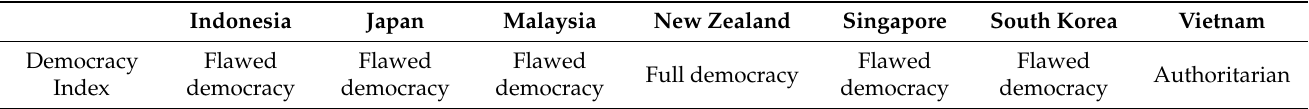
Table 11. Local leadership